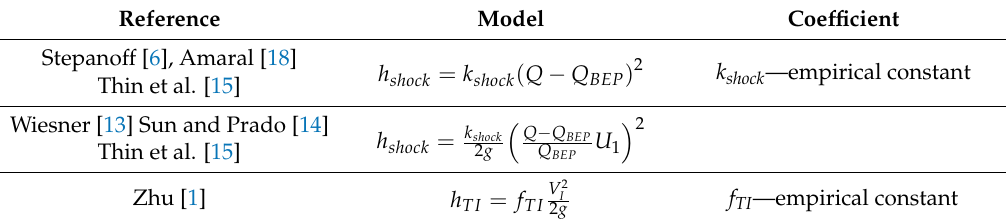
Table 2. Shock loss models in literature.